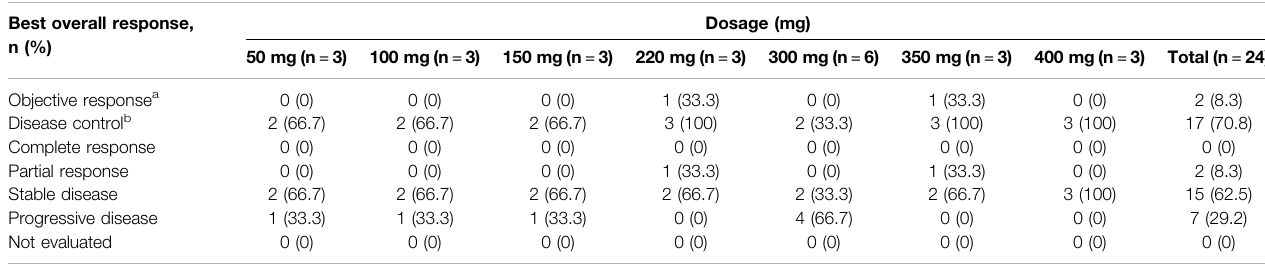
TABLE 5 | Best overall therapeutic responses to larotinib